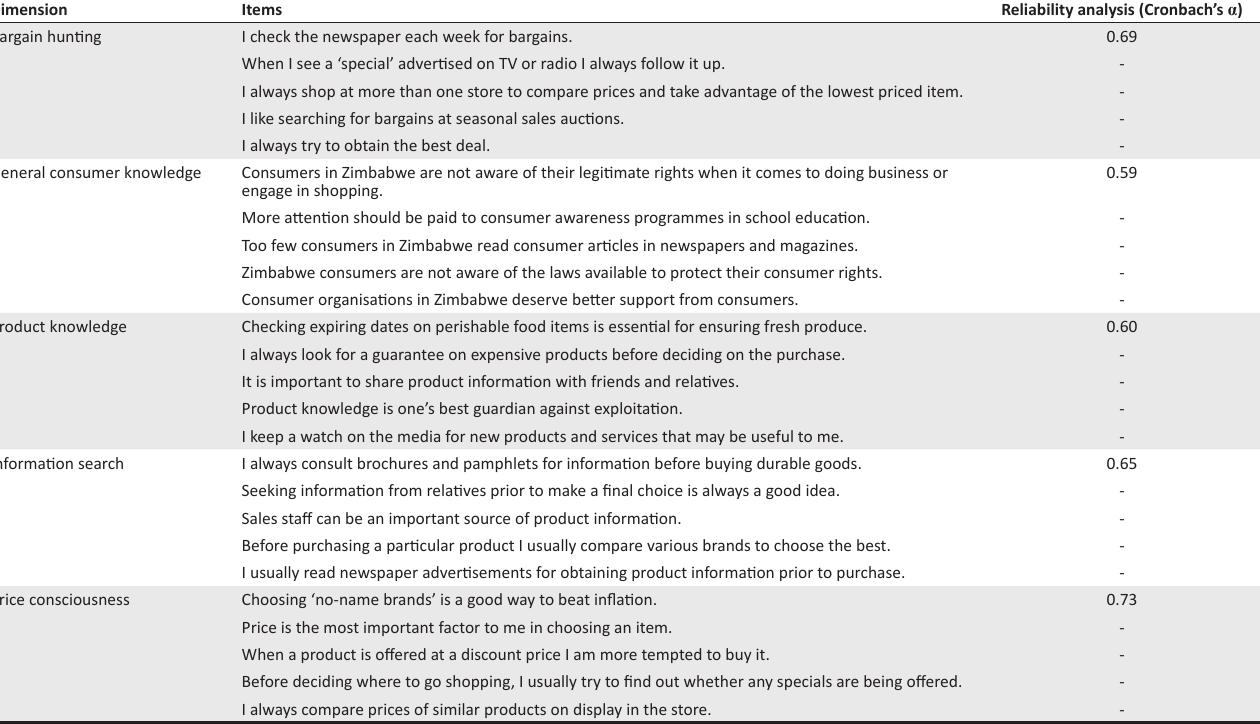
TABLE 2: Dimensionality of the consumer awareness scale. Dimension Items Bargain